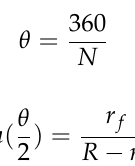
Substituting R 1 and R 2 from Equations (10) and (11), the numbers of fibres in the n th layers of the two arrangements ( N 1 and N 2 ) are: